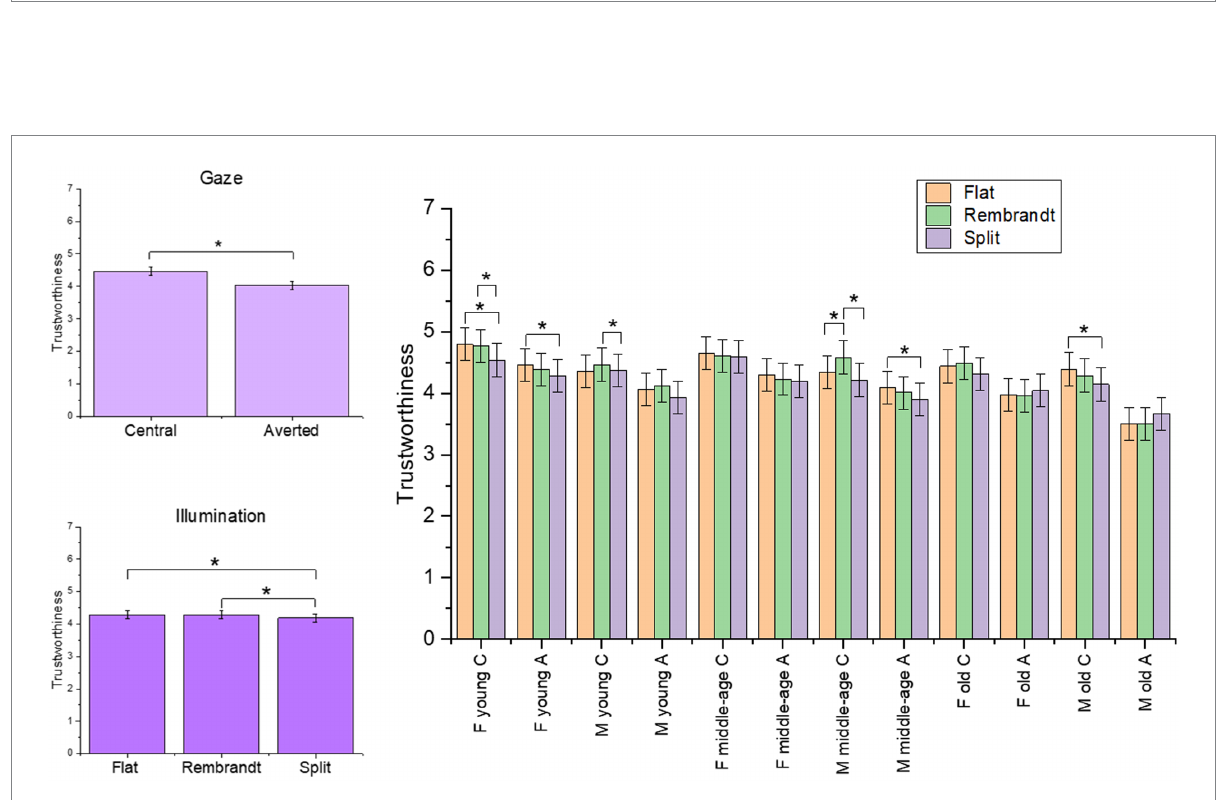
FIGURE 5 Plot of the estimated mean scores from the trustworthiness rating, depicting significant main effects and higher order interaction. The asterisks highlight the significant main effect and significant results form post hoc analyses. C = central gaze, A = averted gaze, F = female models, M = male models. Error bars represent mean standard